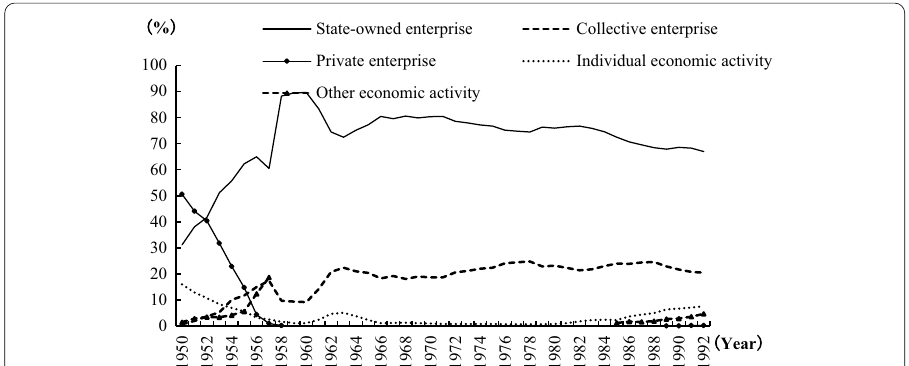
Fig. 1 The proportion of industrial and commercial tax revenue by economic type since the founding of new China. Data source: State Taxation Administration of the People’s Republic of China, 1994, China Taxation Yearbook (1993), Beijing: China Taxation